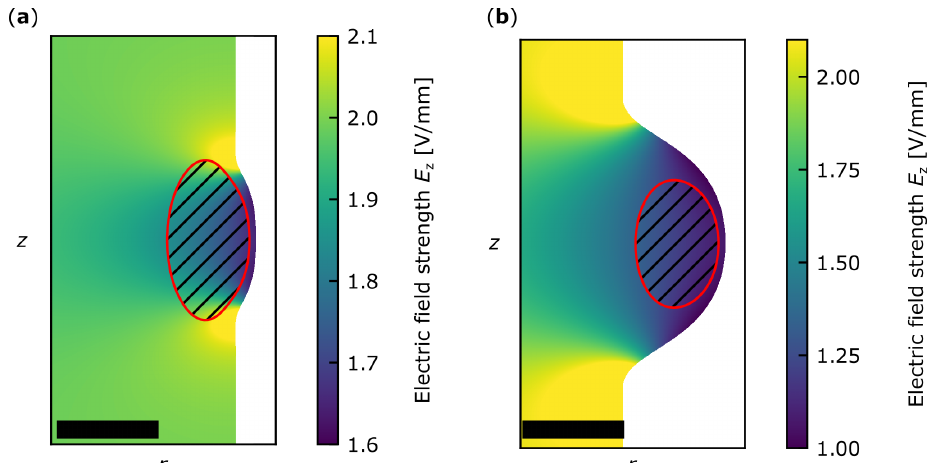
Figure 6. Two examples for different ∆ r in the case of a few-mode WGR with a semicircular bulge with radius r s = 5µm, R 1 = 1000µm and ∆ z = 500µm. The electric field strength is plotted